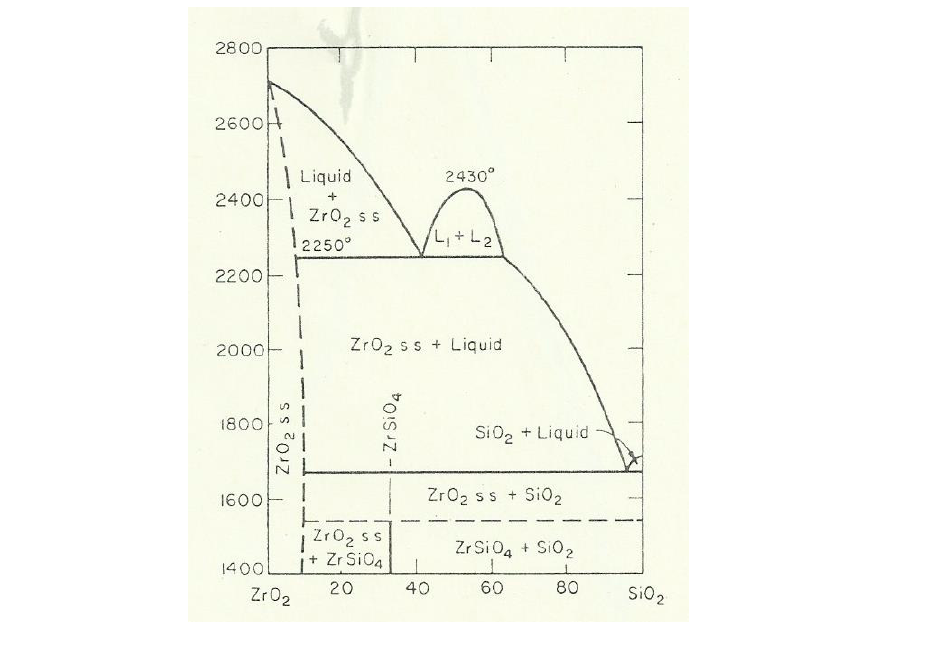
Figure 7. Phase diagram of ZrSiO 4.